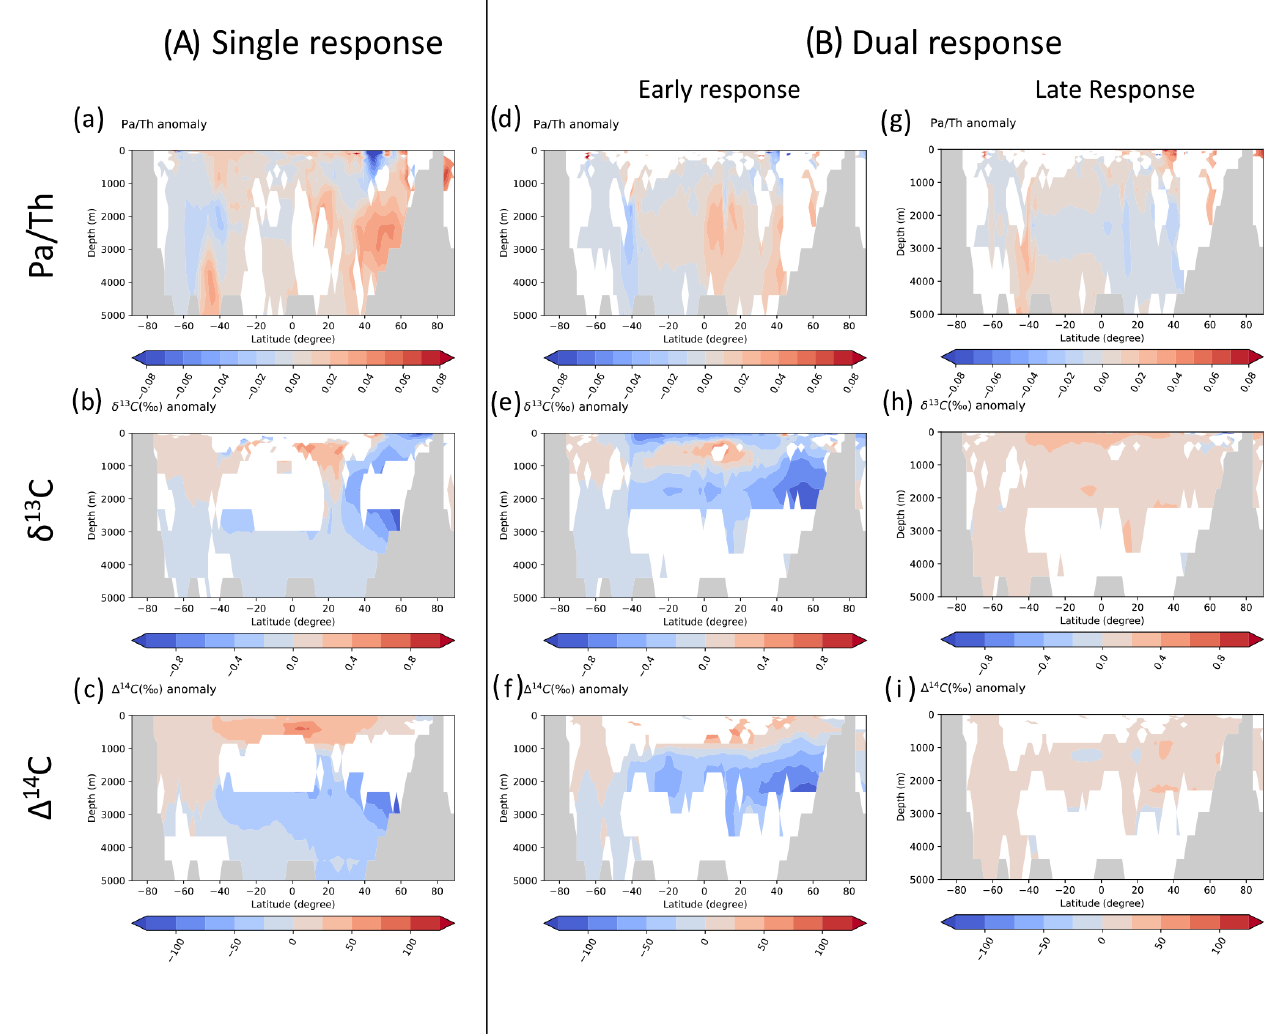
Figure 3. Zonally averaged anomalies for Pa / Th, δ 13 C and (cid:49) 14 C in the western Atlantic basin in the case of a freshwater input in the Nordic Seas. The western and eastern basin are delimited by the topography increase corresponding to the Mid-Atlantic Ridge in the model grid. The anomalies are computed/defined as the proxy response minus the mean of the proxy value during the control period of 300 years under PI conditions (see text). Panels (a) – (c) represent the anomalies for the three proxies in the case where exactly one proxy response has been detected. In the case of two proxy responses, (d) – (f) represent the proxy anomaly value for the early (first) response, while (g) – (i) represent the proxy anomaly for the late (second) proxy response. Areas left blank were not showing a single response (A) or not showing exactly two responses (B). In each subplot, the grey contours represent the ocean bottom. Single and dual responses are mutually exclusive on a per location basis. Since (A) and (B) are showing zonal averages, overlaps may arise from different locations with the same latitude but different